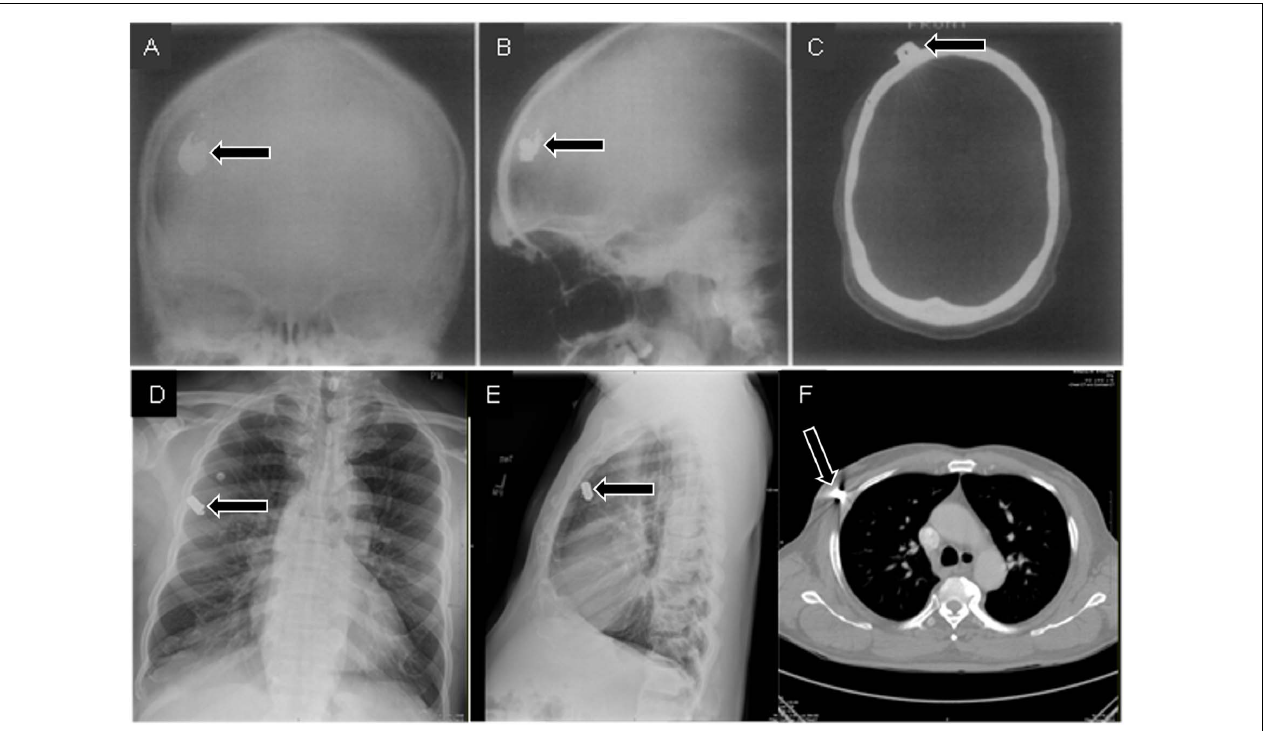
FIGURE 8 | Frontal (A) and lateral (B) radiographs of a patient who suffered a gunshot wound to the skull seem to indicate that the bullet is within the skull. However, the skull does not appear to be fractured, and there is no indication that the bullet actually passed through the skull. A CT scan (C) provided the critical viewpoint to conclude that the bullet was just underneath the scalp ( A–C from Daffner, 1989). In a separate case, frontal (D) and lateral (E) radiographs seem to indicate that a bullet is within the lung. However, a CT scan (F) revealed that the bullet was in the surrounding